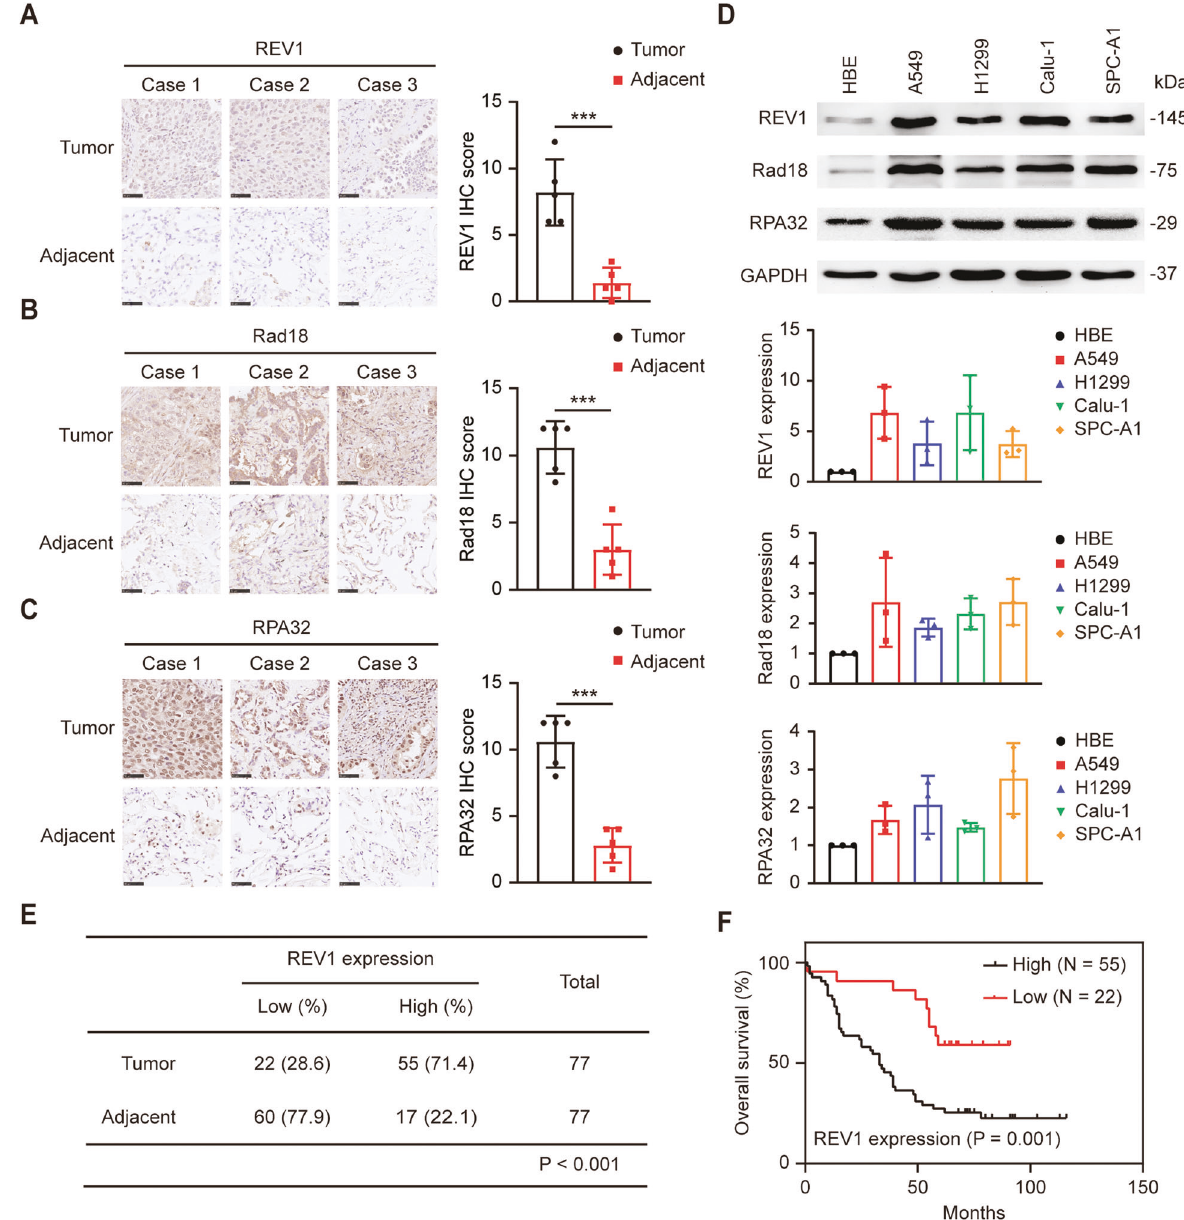
Fig. 1 REV1 is overexpressed and indicates poor prognosis in lung cancer. A – C Representative immunohistochemical staining images and IHC scores of REV1, Rad18, and RPA32 in lung cancer and paracancerous tissues. *** P < 0.001 ( n = 5). Scale bar: 50 µm. D Protein levels of REV1, Rad18 and RPA32 in different cell lines, with the relative expression statistics from three independent experiments. The data are presented as the means ± SDs ( n = 3). E Statistical analysis of REV1 expression in the lung adenocarcinoma tissue microarray. F Relationship between the expression of REV1 and the prognosis of patients with lung cancer.